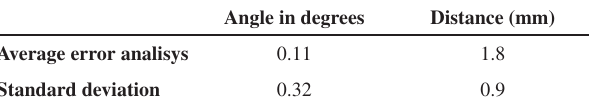
Table 4 - PAS/SAPO computacional errors for angle and dis- tance measurements: measurements obtained with the PAS/ SAPO compared to the actual values (known